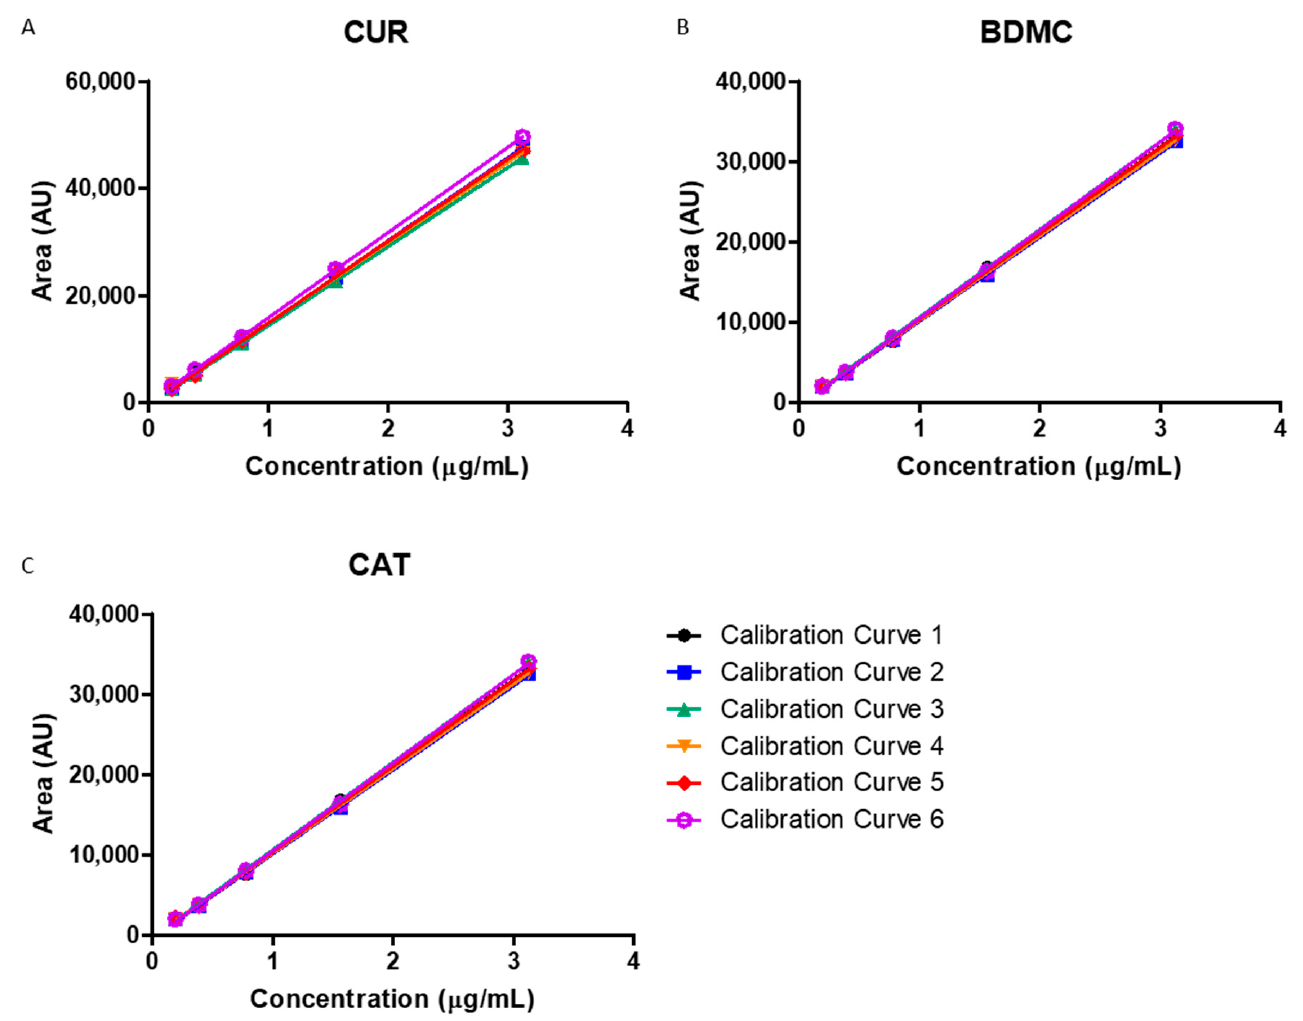
Figure 2. Linearity of the analytical method for curcuminoids assessed by the linear regression of the curves of ( A ) CUR; ( B ) BDMC; and ( C ) CAT ( n = 6).